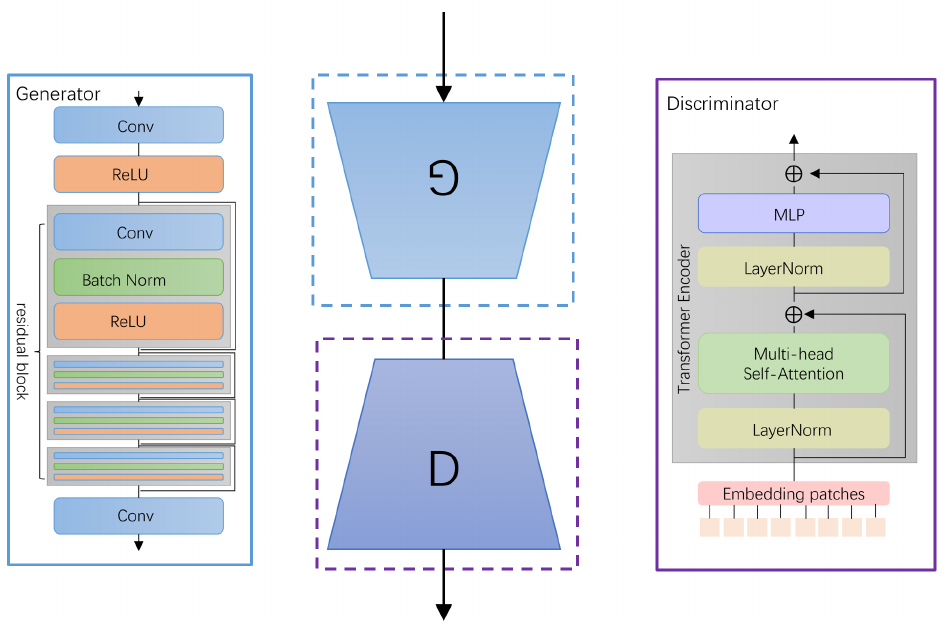
Figure 4. Transformer generative hairstyle (TGH) module. The module consists of a generator (G) and a discriminator (D). The generator uses the ResNet network, and the discriminator uses a transformer for image patch attention.